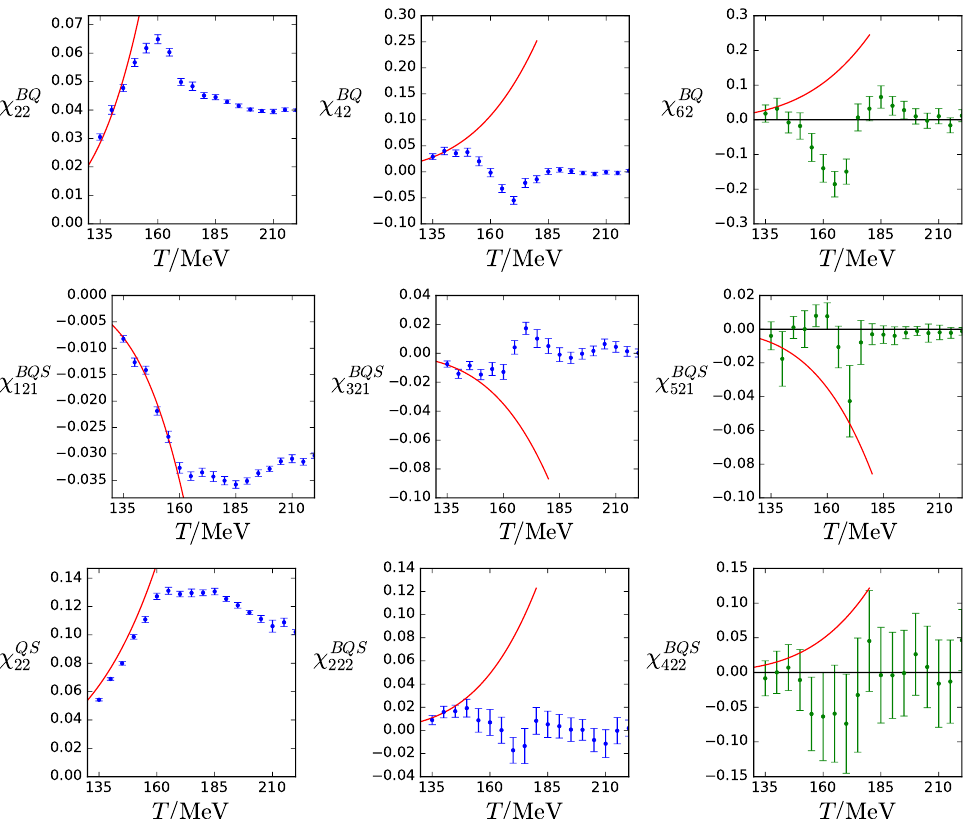
Figure 12 . Results containing two electric charge derivatives on the various correlators on our 48 3 (cid:2) 12 lattice as functions of the temperature. Green data points denote our estimates for the high orders, these were (cid:12)tted using a prior distribution. The red curves are the HRG model results. Charge correlators without baryon derivative (here (cid:31) QS discretization